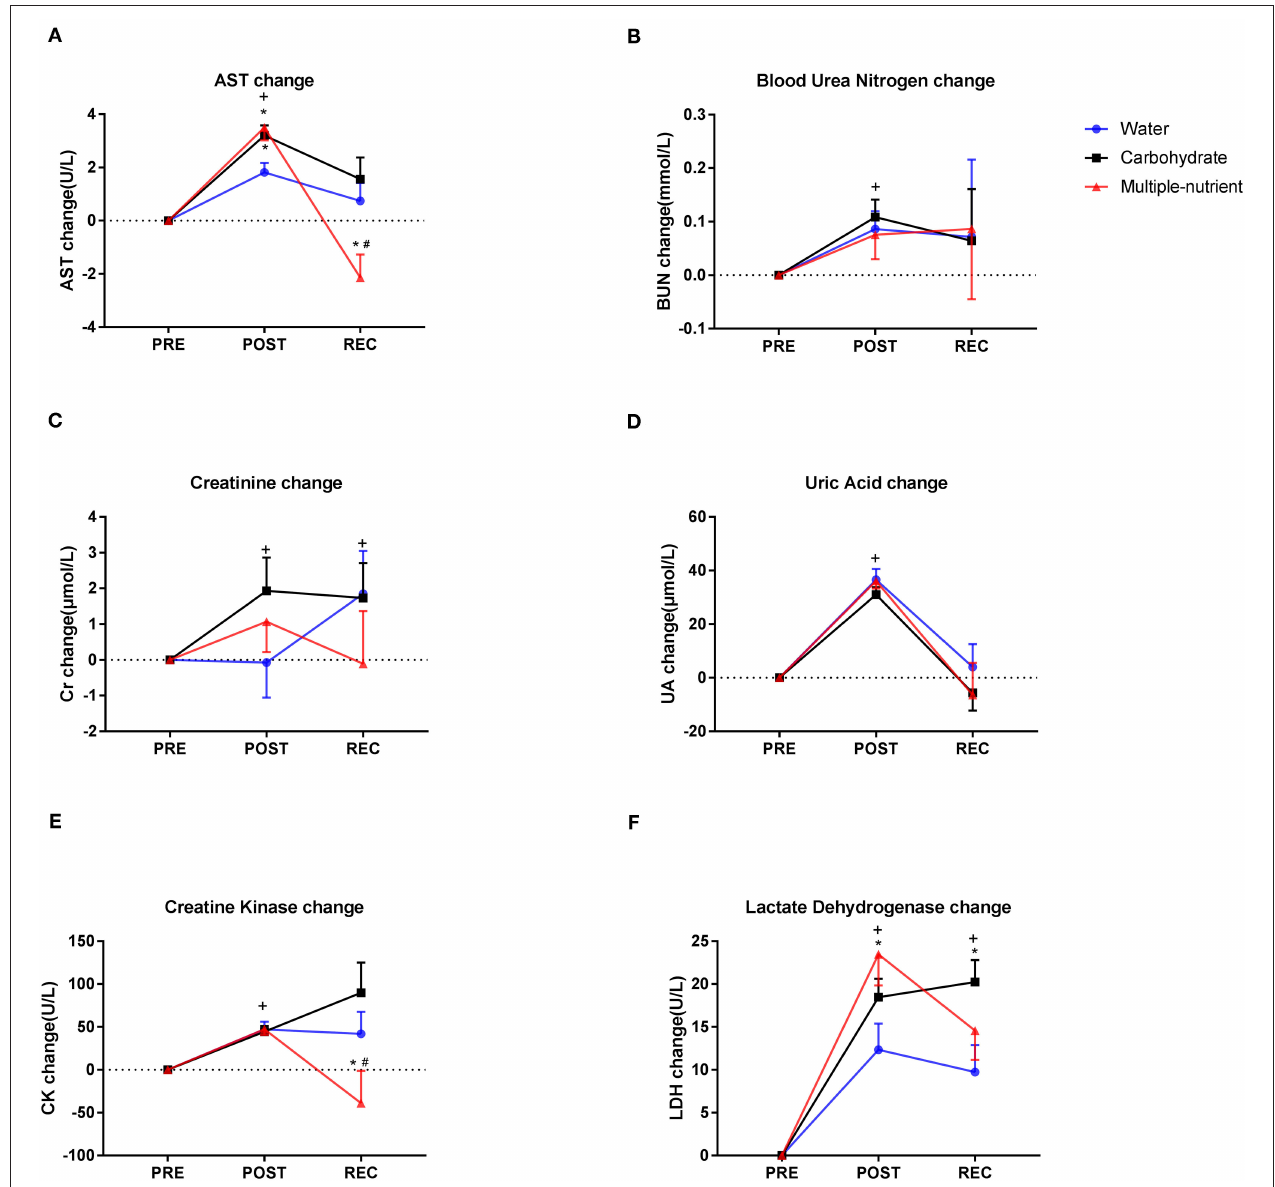
FIGURE 3 | Changes in biochemical parameters in the short-term supplement trial. Changes in AST (A) , BUN (B) , Cr (C) , UA (D) , CK (E) , and LDH (F) levels in different experimental groups. Values are mean ± SEM. PRE, prior running test; POST, immediately after running test; REC, 24h after running test. Change at POST equals POST minus PRE, change at REC equals REC minus PRE. *Indicates difference compared with water, p < 0.05. # Indicates a difference compared with glucose, p < 0.05. + Indicates difference compared with PRE, p <